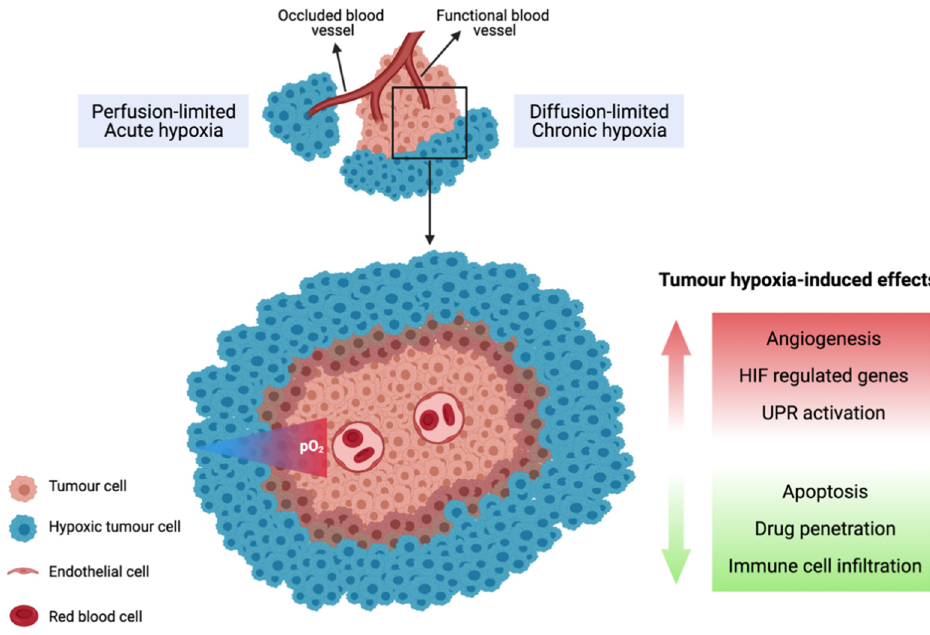
Figure 1. Illustration of chronic and acute tumour hypoxia. Diffusion-limited hypoxia occurs when cells are located near the diffusion limit of oxygen. Perfusion-limited hypoxia arises due to temporary occlusion of tumour vasculature.